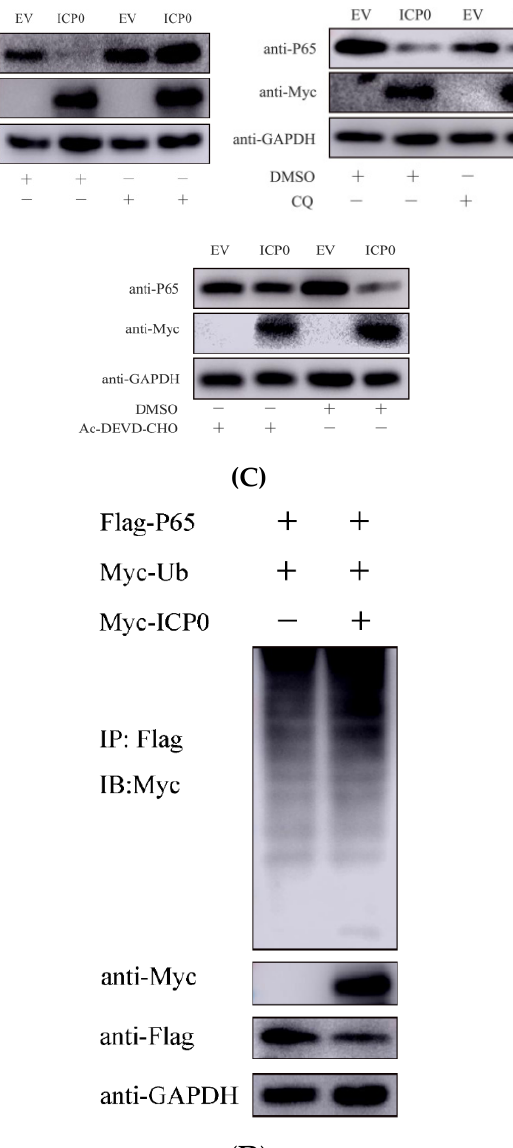
Figure 4. ICP0 targets p65 to inhibit NF- κ B signaling. ( A ) PK15 cells were co-transfected with pCMV-Myc empty vector (1.0 µg) or Myc-ICP0 (1.0 µg) plasmids and Flag-p65 (1.0 µg) plasmids for